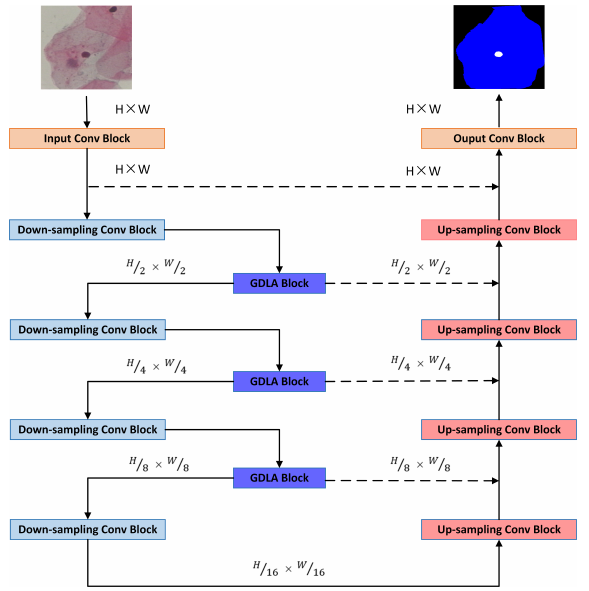
Figure 4. Illustration of the network structure used with the GDLA module embedded in